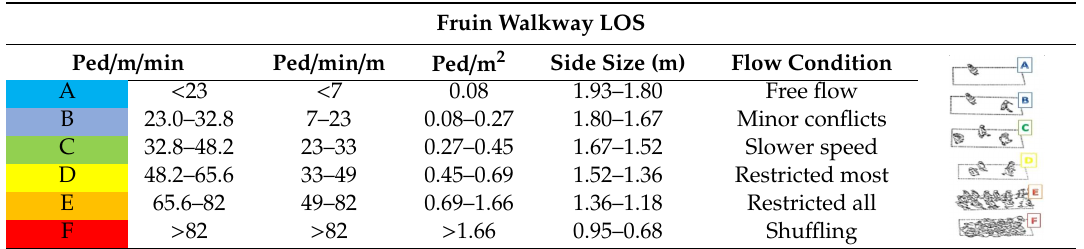
Table 3. Fruin Walkaway LOS.